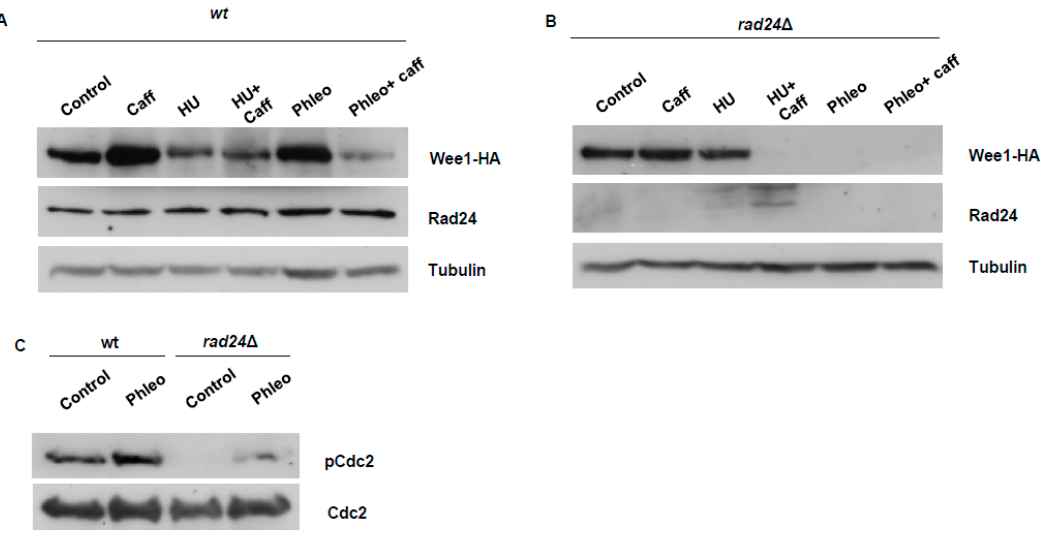
Figure 3. Ca ff eine suppresses genotoxin-induced Wee1 accumulation in S. pombe . ( A ). Cells expressing Wee1-HA were cultured with 10 mM ca ff eine alone or in combination with 20 mM HU or 10 µ g / mL phleomycin as indicated. Cultures were pre-treated with HU or phleomycin for 2 h and then for a further 2 h in the presence or absence of ca ff eine. ( B ). Wee1-HA rad24 ∆ cells were treated as in A. ( C ). Wt cells expressing Wee1-HA and Wee1-HA rad24 ∆ cells were exposed to 10 µ g / mL phleomycin for 1 h. Total protein lysates were resolved by SDS-PAGE and membranes probed with antibodies directed against phospho-Cdc2 and Cdc2.